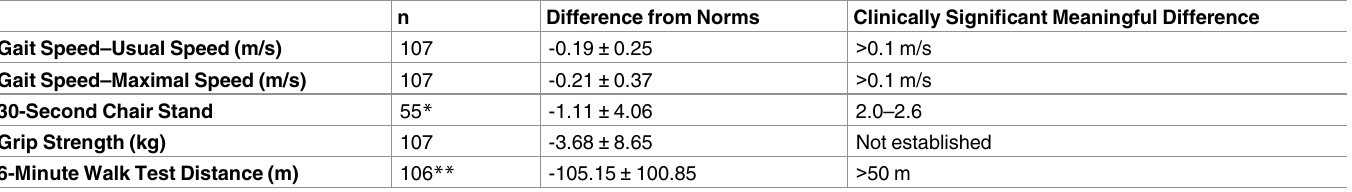
Table 4. Differencesin physical function between HIV-infected study participants and normal referenceranges (controlled for age and gender). n Difference from Norms Clinically Significant Meaningful Difference -0.19 ±